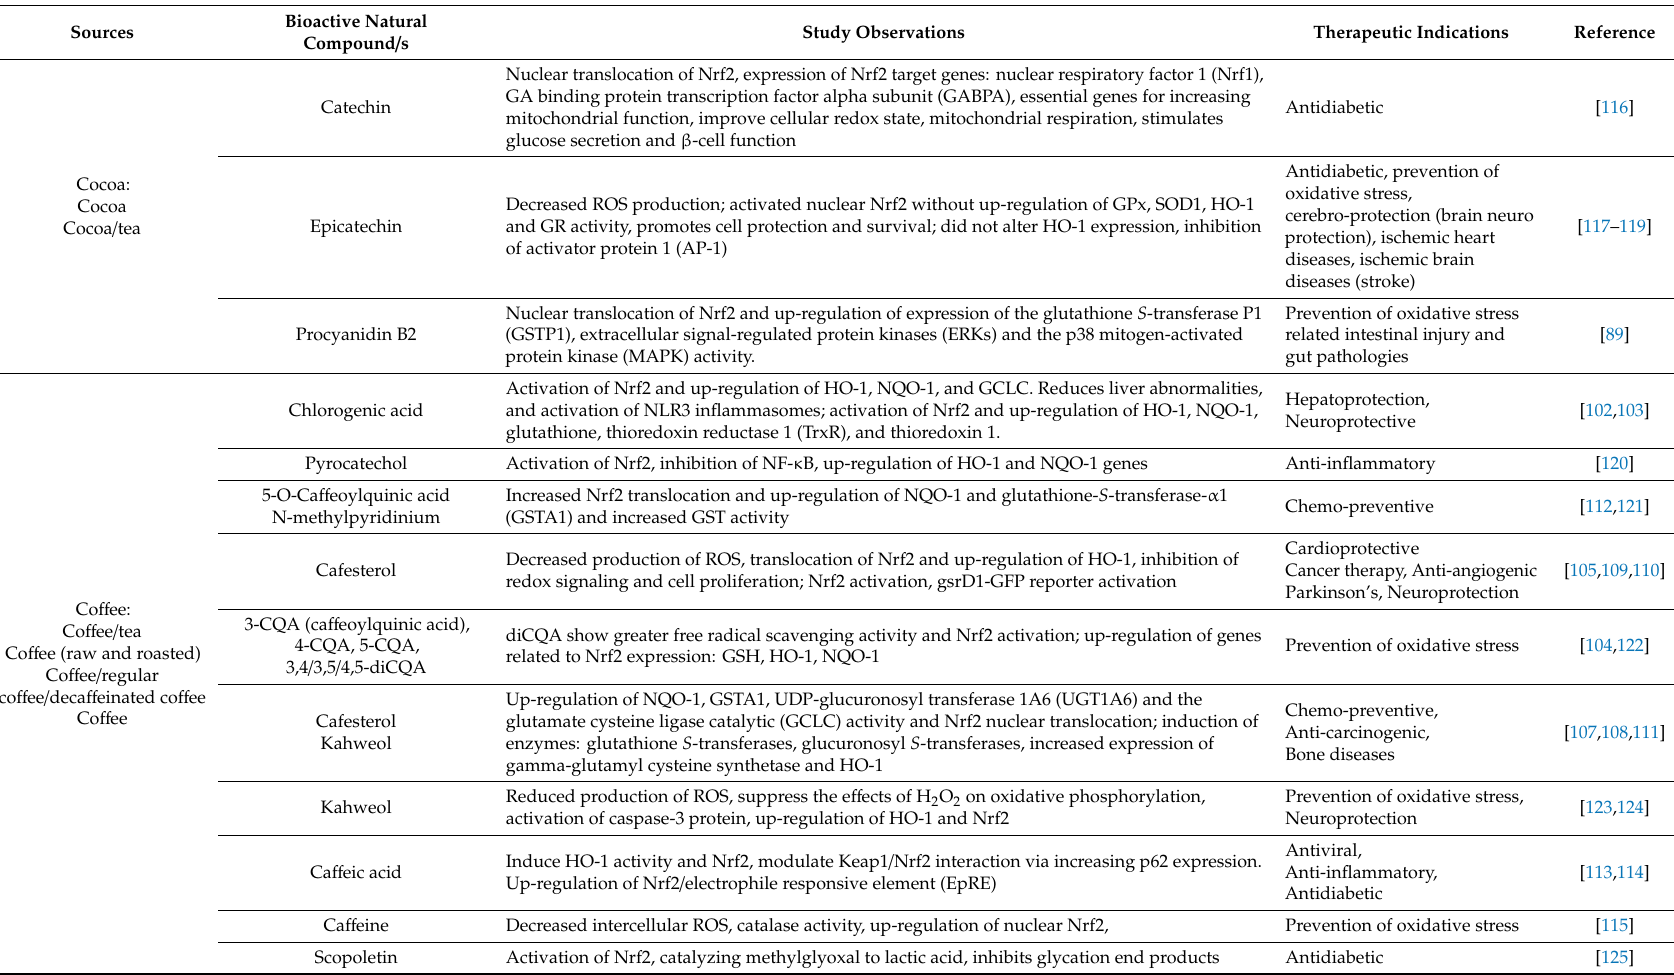
Table 4. List of phytochemicals present in co ff ee and cocoa as Nrf2